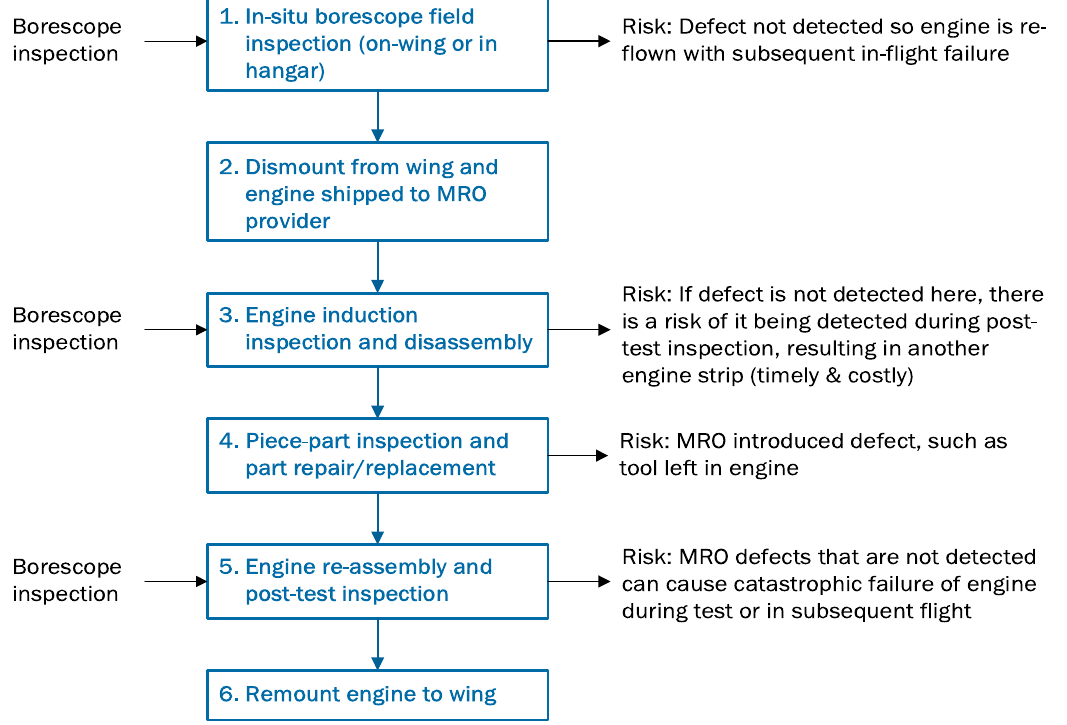
Figure 1. Maintenance, repair and overhaul (MRO) process with borescope inspection procedures and risks.